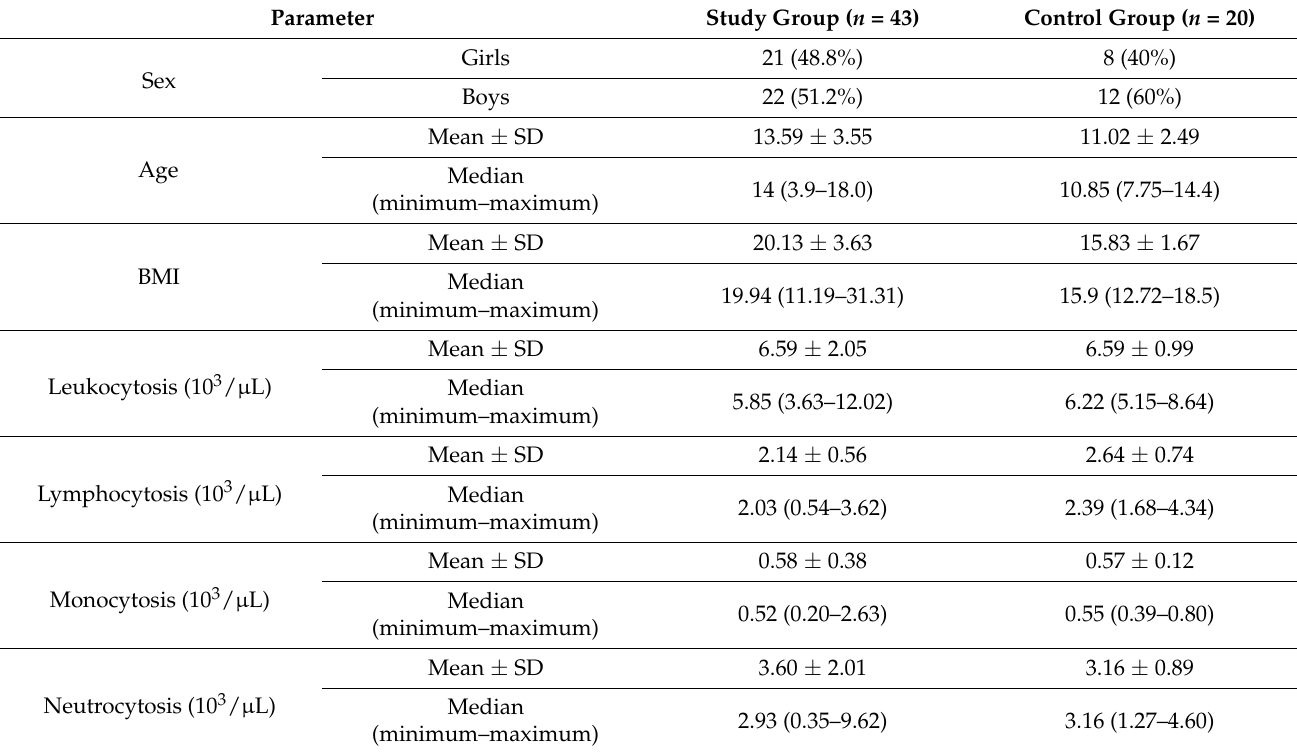
Table 9. Characteristics of selected parameters and blood-morphology parameters of patients from the study and control